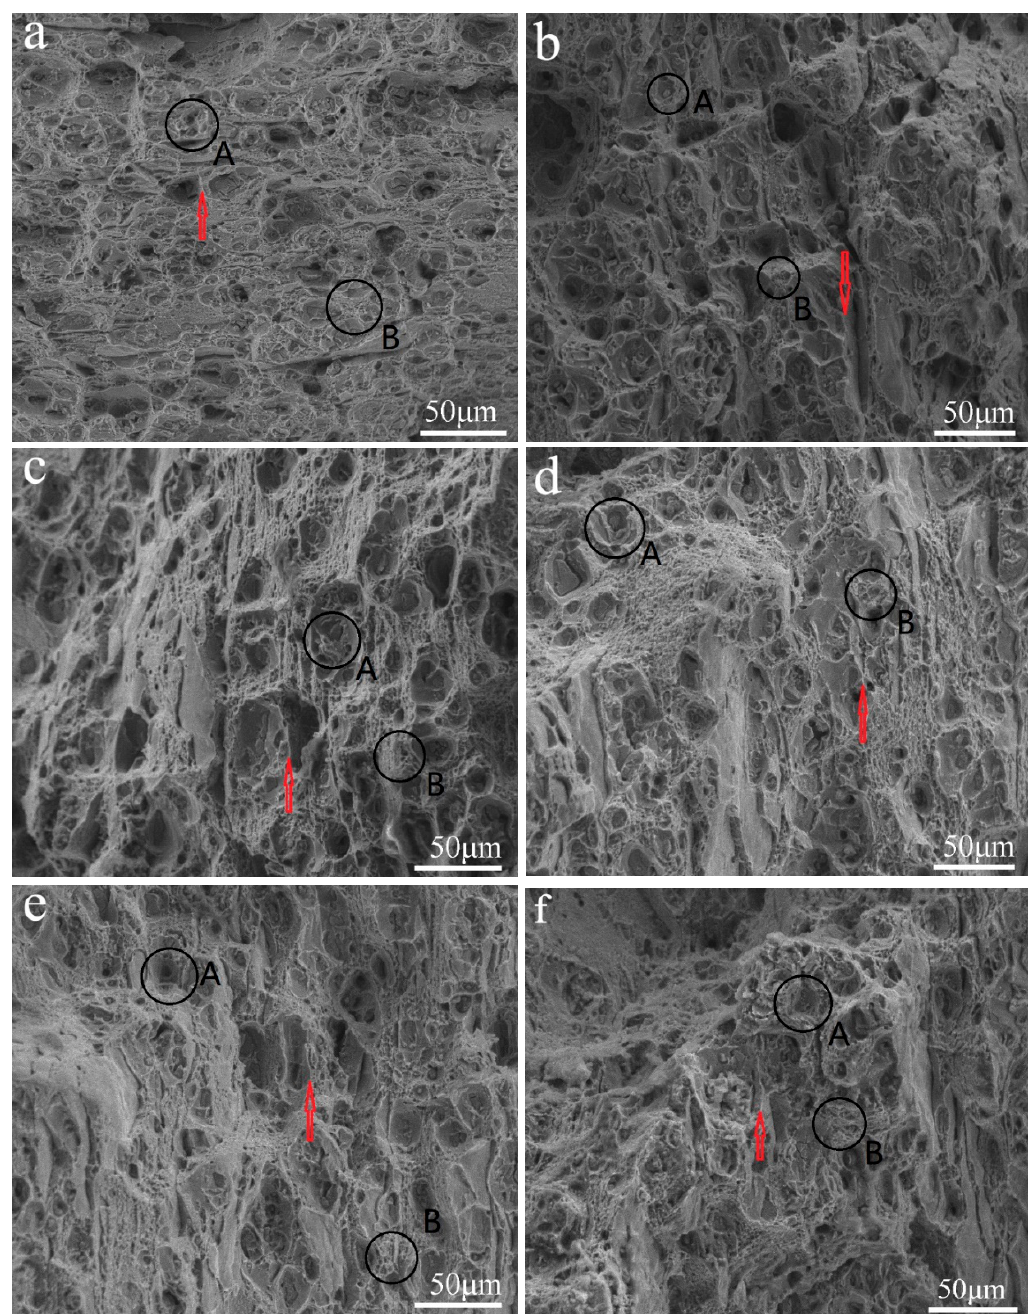
Figure 4. Tensile fracture morphologies of the 7075 Al sheets subjected to one-step aging for various durations: ( a ) 8 h, ( b ) 10 h, ( c ) 12 h, ( d ) 14 h, and ( e ) 16 h at 140 °C; ( f ) DA treatment (3 h at 120 °C and 3 h at 160 °C).